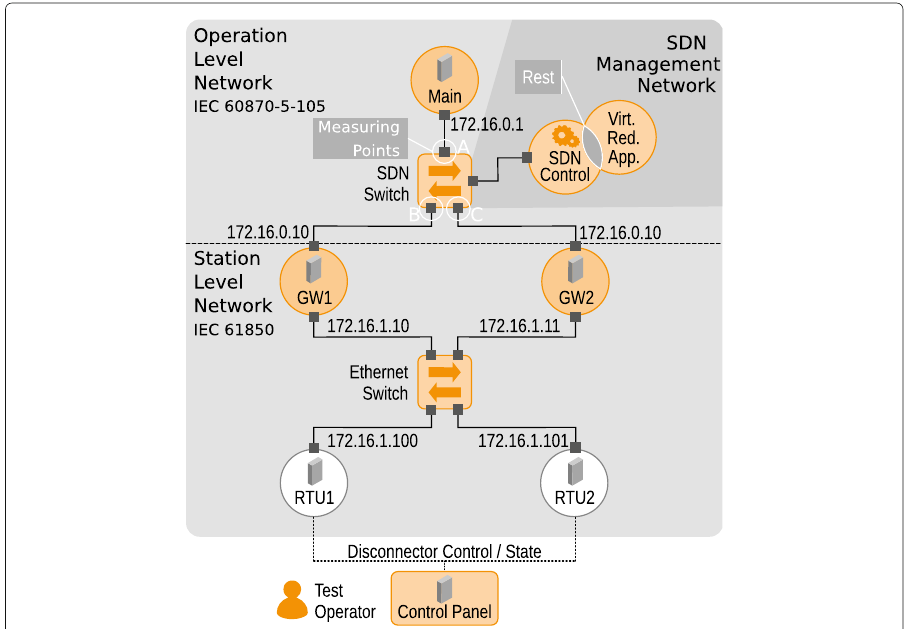
Fig. 3 In difference to real existing environments, the demonstrator is equipped with single switches instead of complete networks at operation and station level